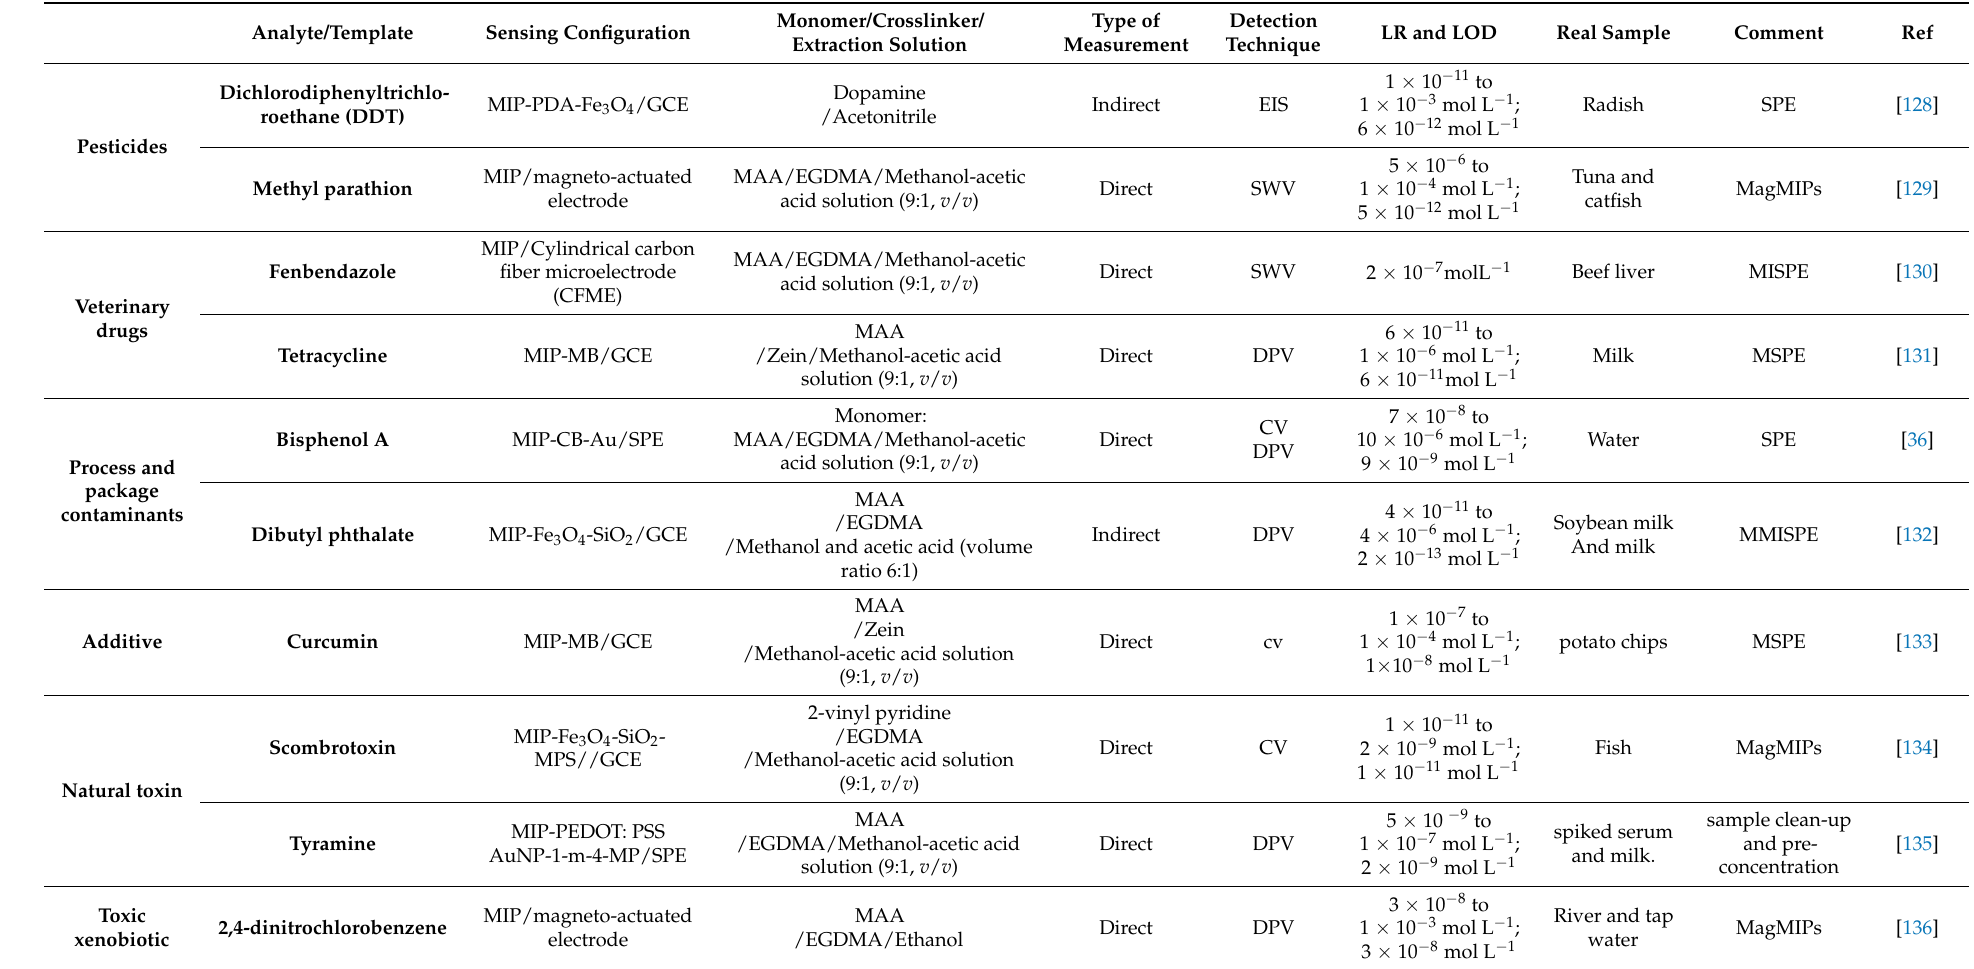
Table 3. MIP-Combined Electrochemical sensors for food sample